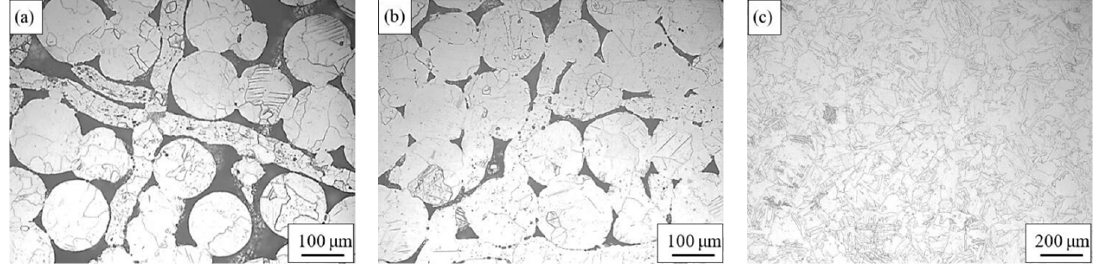
Figure 5. OM micrographs of samples sintered at different sintering temperatures: ( a ) 800 °C, ( b ) 900 °C and ( c ) 1000 °C. and ( c ) 1000 ◦